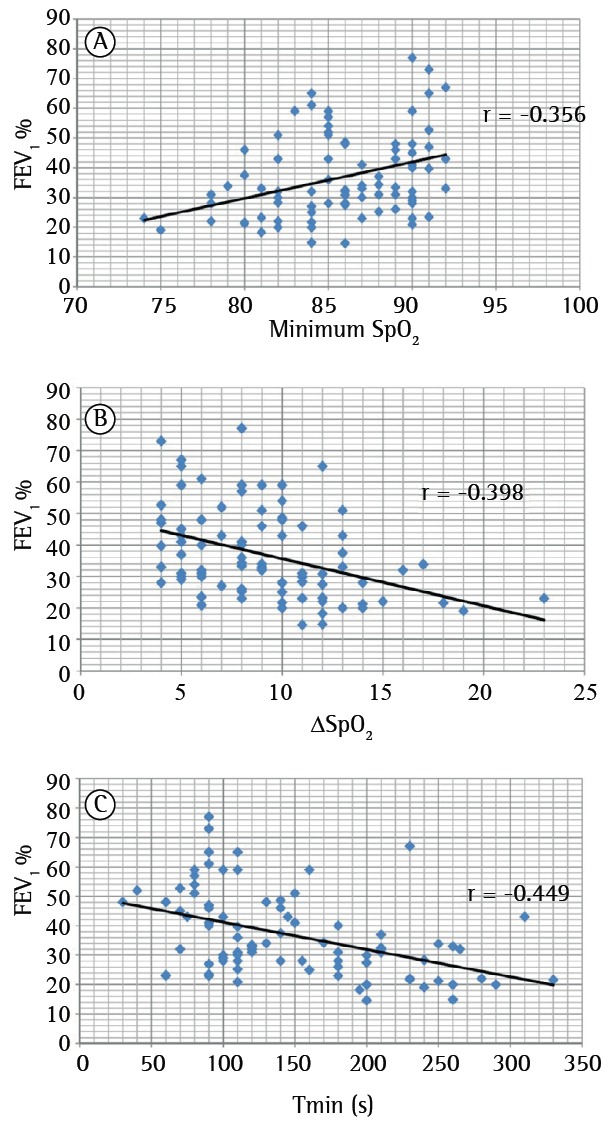
Correlations of changes in FEV1% with the minimum
SpO2 (in A), ΔSpO2 (in B), and time to the minimum
SpO2 (Tmin; in C).